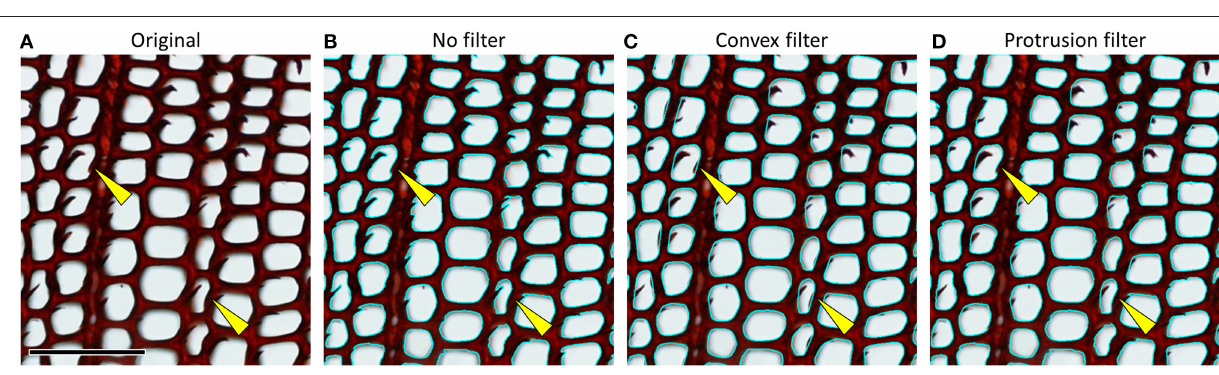
FIGURE 12 | (A) Cross-section of a Pinus sylvestris wood piece showing ripped-off cell walls. (B) Same sample with overlay of detected lumen outlines (cyan) without any correction, resulting in measurement errors. (C) A convex outline filter can correct such artifacts, but may also cut off true concavities in the lumen outlines, e.g., due to pit inflections (see examples highlighted by yellow arrows), while (D) a more powerful “protrusion filter” (as implemented in the image-analysis tool ROXAS) better discriminates between artifacts and true concavities. Scale bar = 100 µ